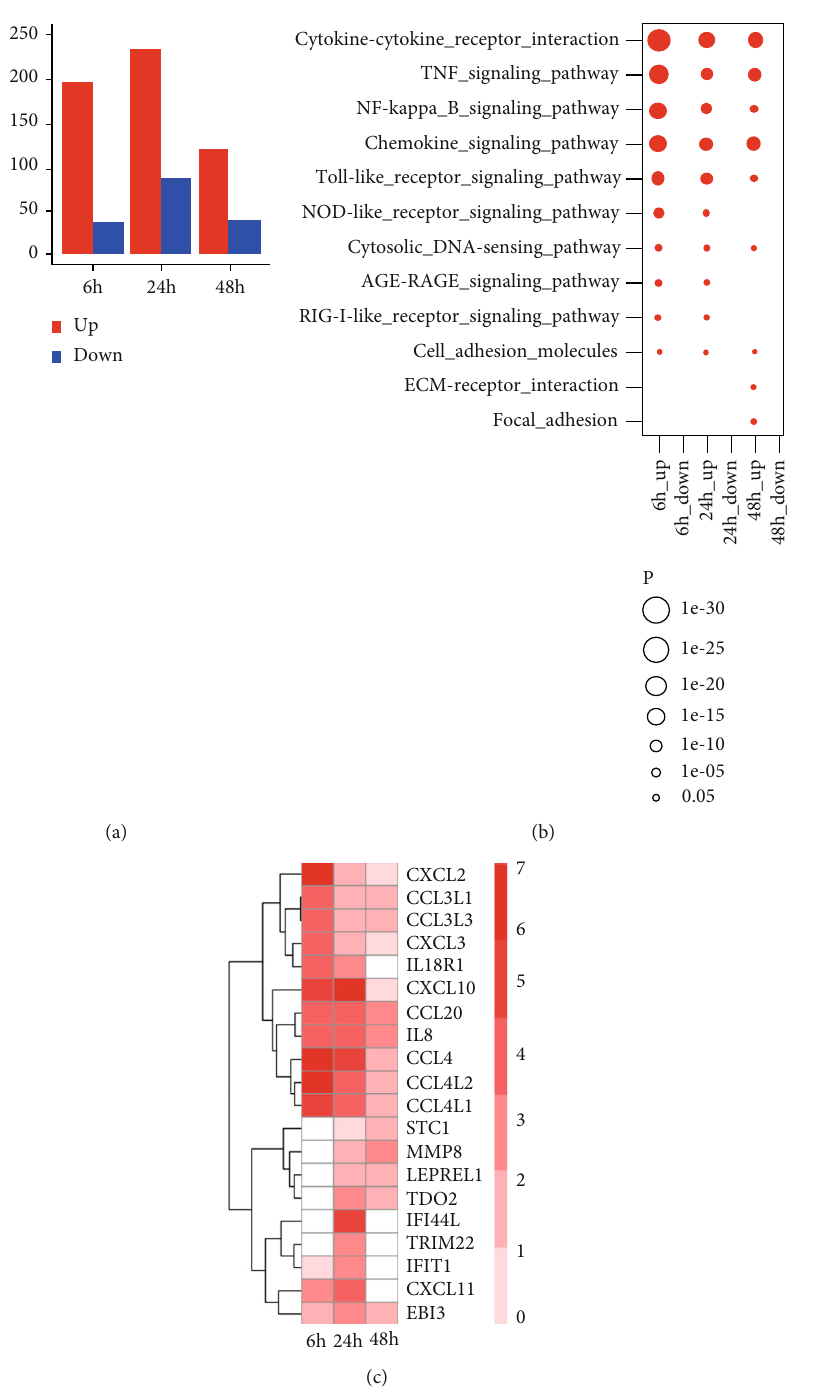
Figure 1: Di ff erential gene analysis for M. tuberculosis H37Rv-infected macrophages by RNA-sequence. (a) Number of di ff erentially expressed genes at time points of 6, 24, and 48 h in M. tuberculosis H37Rv-infected macrophages. (b) Red circle size means signi fi cant enrichment of upregulated genes by KEGG pathway enrichment. Each score represents base 10 to the minus 5 logarithm of enrichment P values. (c) Gene expression signature of top 10 upregulated di ff erentially expressed genes from each time point of M. tuberculosis H37Rv-infected macrophages. The colour denotes log2 fold change of gene expression. Colour red indicates upregulation and blue means